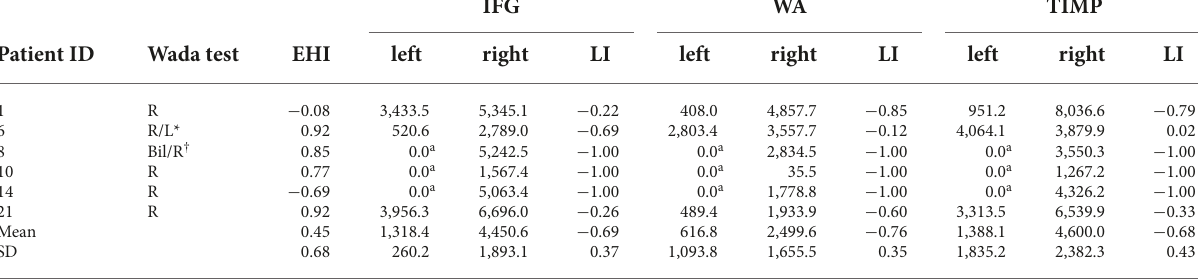
TABLE 4 MEG sum of thresholded and cluster corrected t -values in left and right ROIs and laterality indices in patients with atypical language dominance revealed by Wada test. IFG